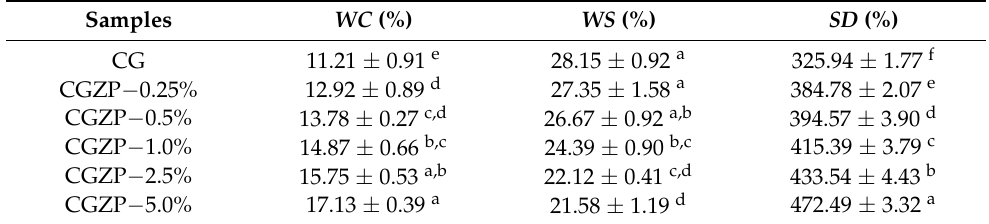
Table 1. Thickness, water content ( WC ), water solubility ( WS ) and swelling degree ( SD ) of the films. Samples